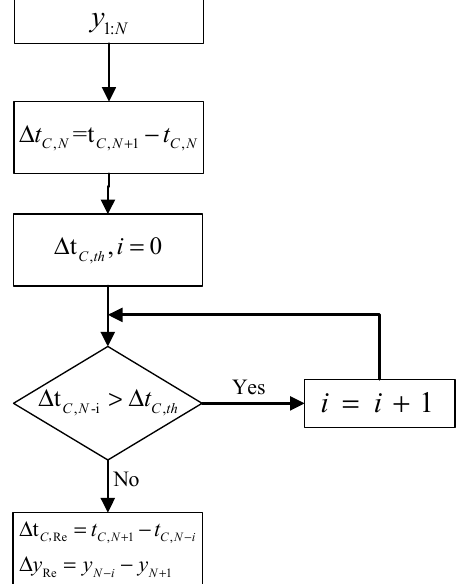
Figure 3. Capacity degradation rate curve of No. 5 battery by calendar time.